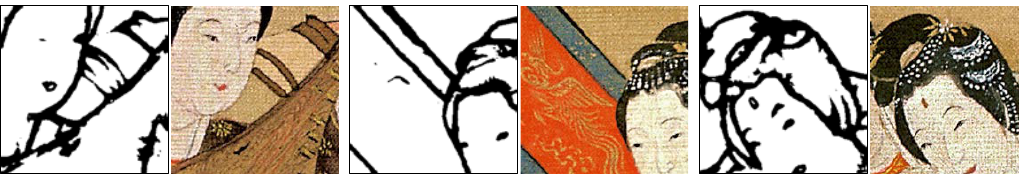
Figure 6. Comparison of experimental results to Pix2pix. From top to bottom: input sketch, our deep network, Pix2pix and the ground truth.